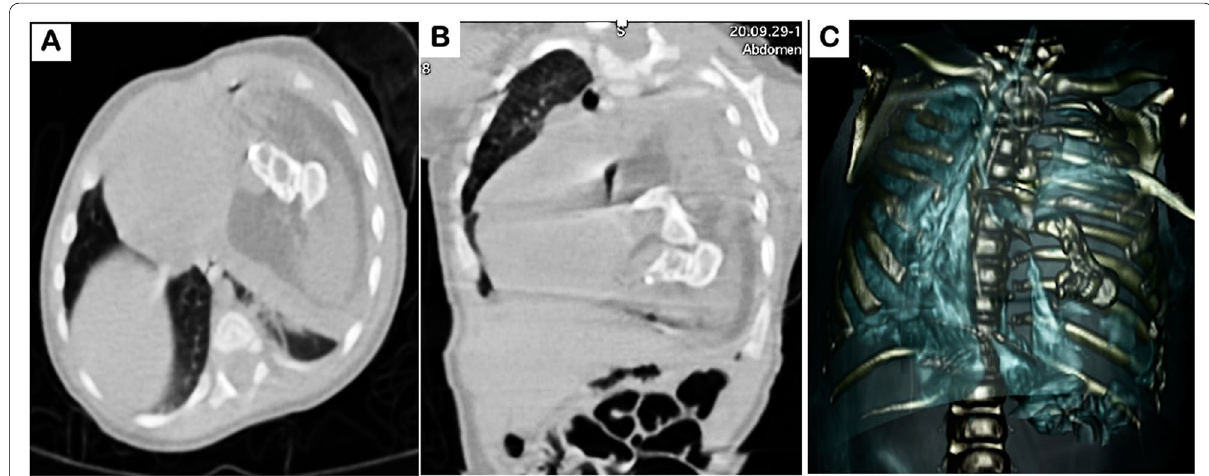
Fig. 2 Chest CT scan and 3D reconstruction series. A , B Heterogeneous mass spanning the entire left hemithorax to the anterior and middle mediastinum, deviation of mediastinal organs toward the right hemithorax, compression of the left lung, and hypertrophy of the left lower lobe; mass centered by an opacity of bone density. C , D Reconstruction showing the residual left lung, the axial skeleton of the